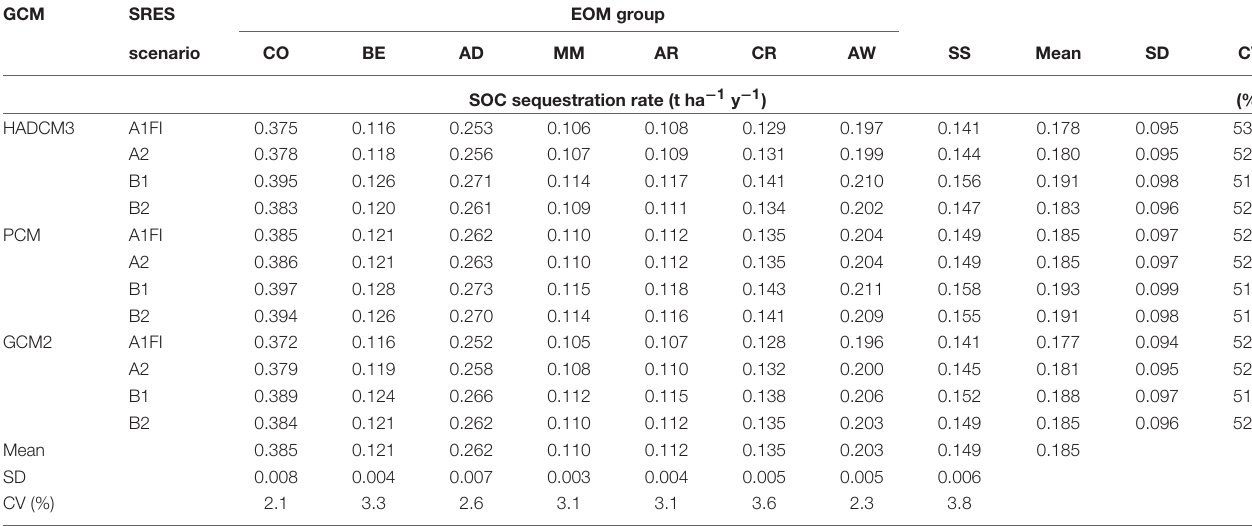
TABLE 3 | Modeled soil C sequestration potential for different EOM groups and climate scenarios in Italian agricultural soils amended for 100 years at a rate of 1t C ha − 1 y − 1 . GCM SRES scenario